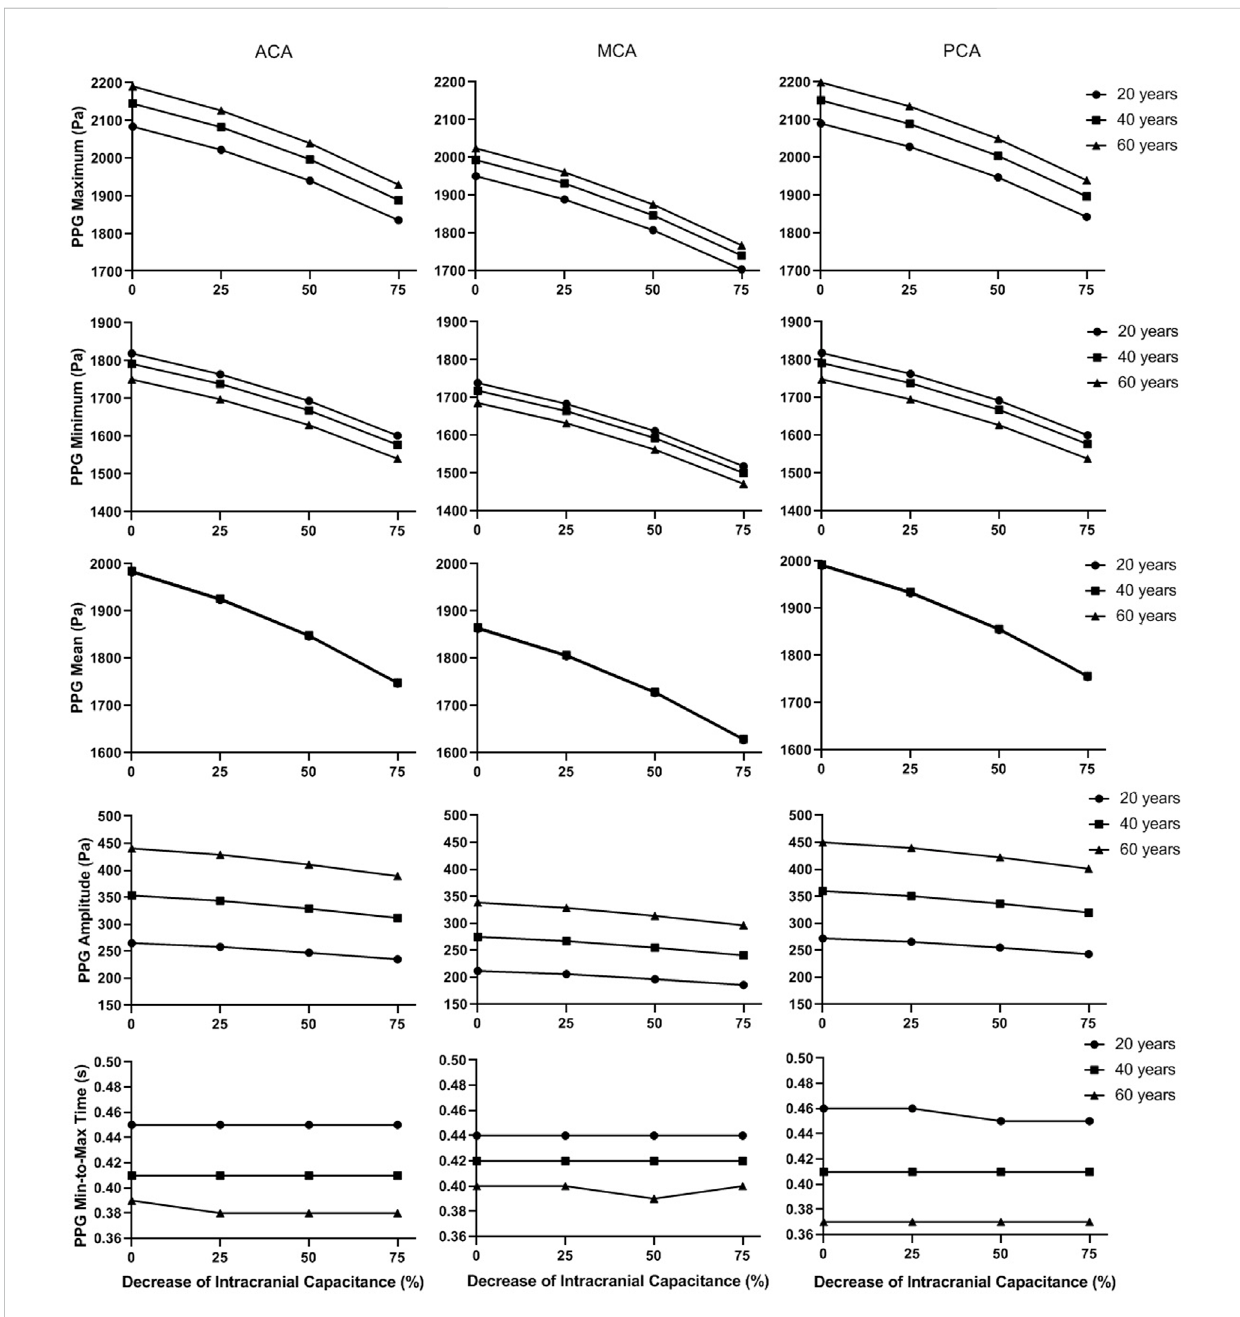
FIGURE 9 The basic waveform features of the simulated PPG signals in different intracranial capacitance conditions.